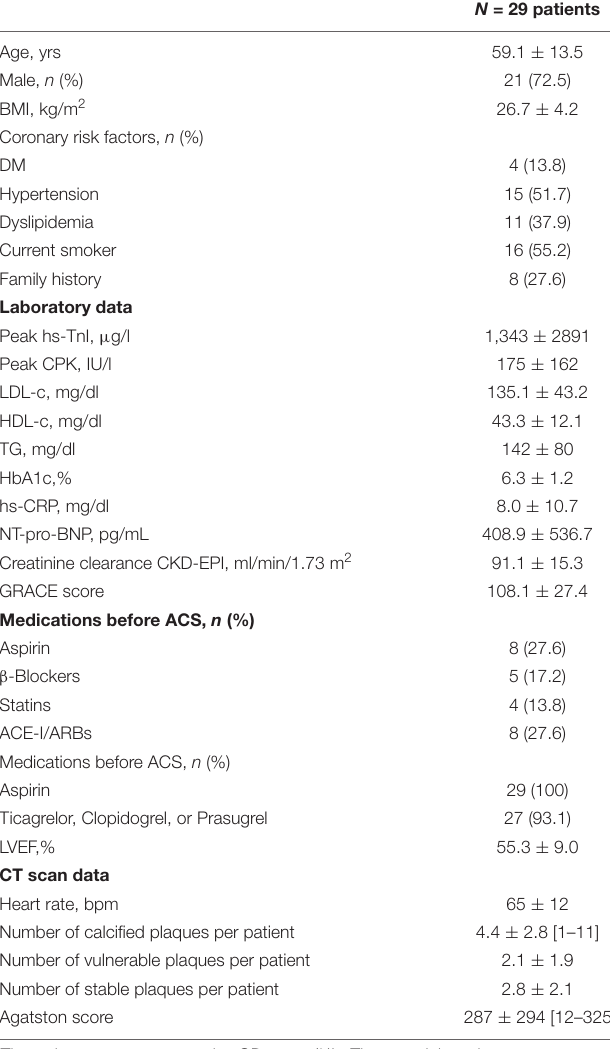
TABLE 1 | Baseline characteristics of the patients. TABLE 2 | Comparison of calcified plaques depending on the vulnerability profile by optical coherence tomography (OCT).